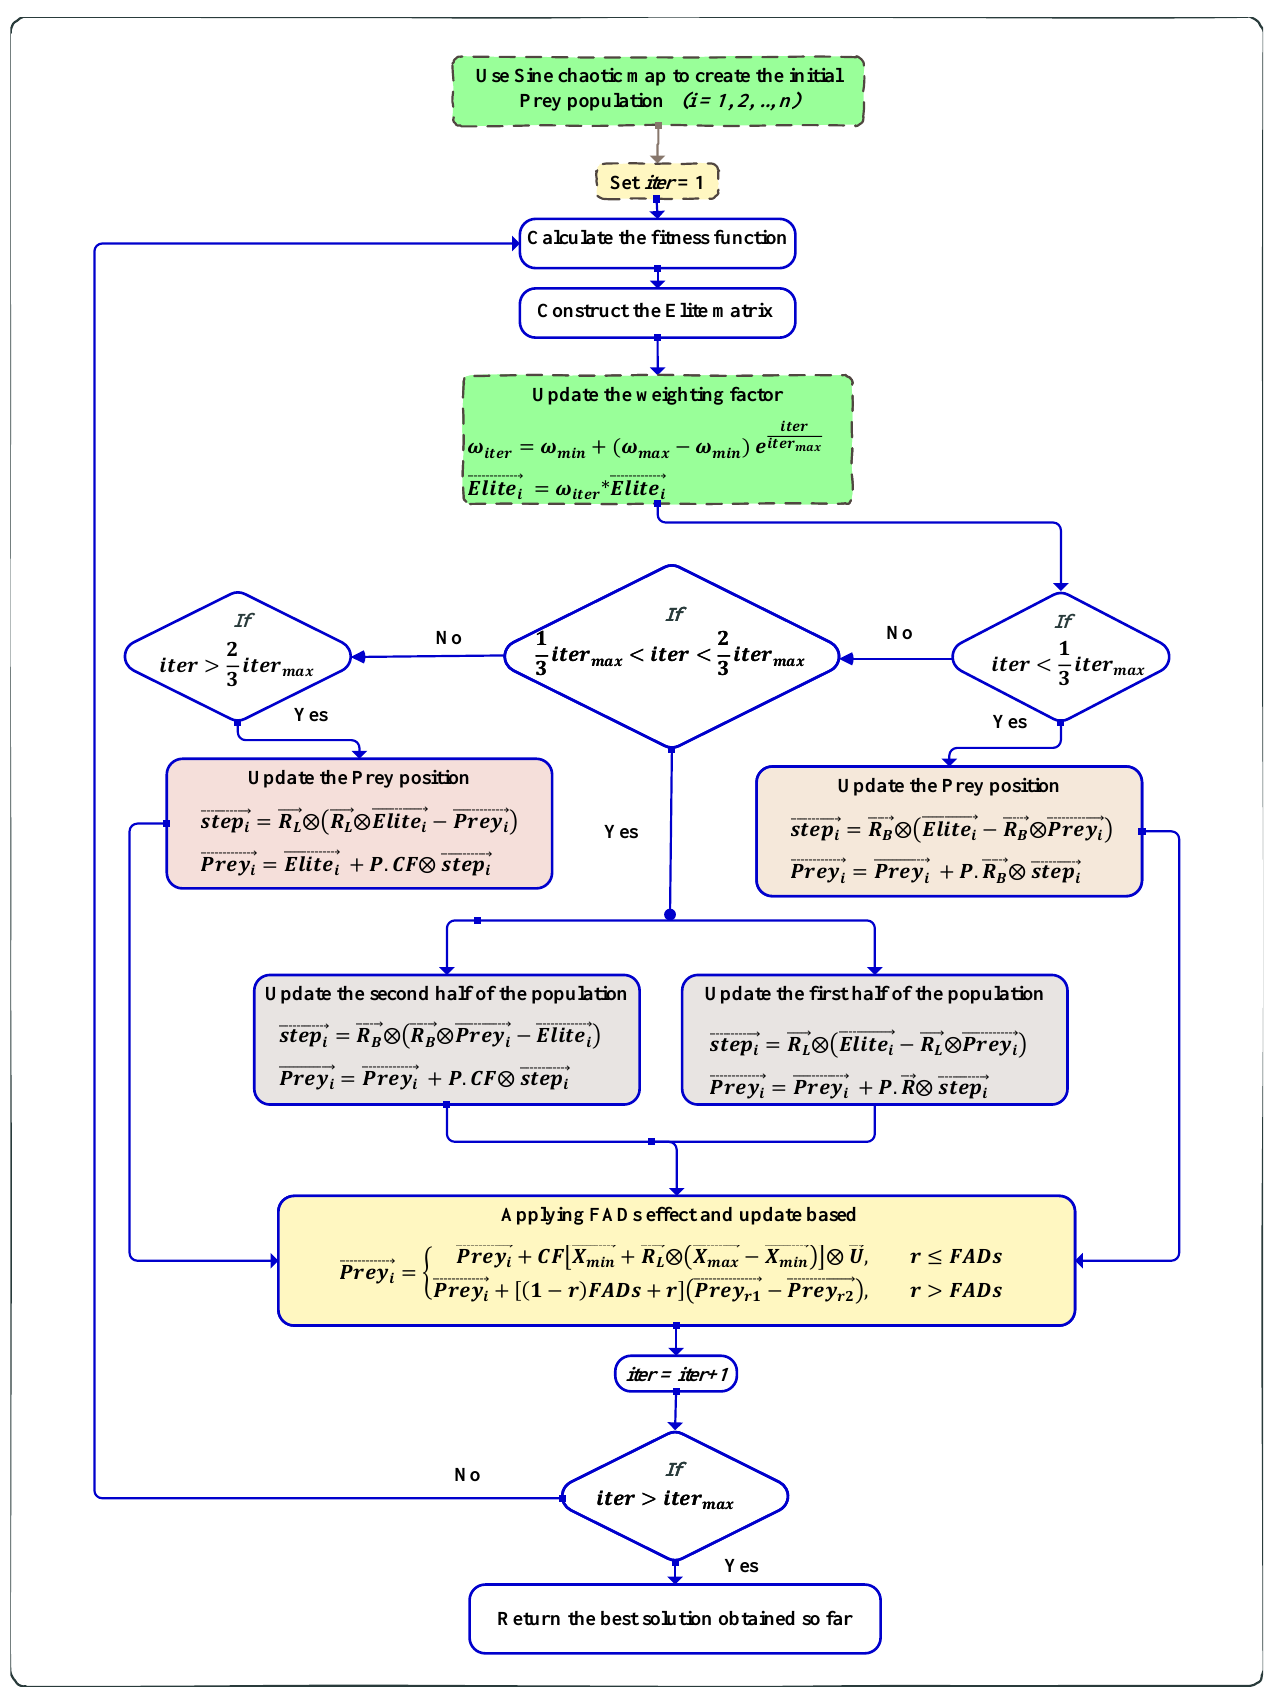
Figure 8. The flowchart of the modified Marine Predators Algorithm